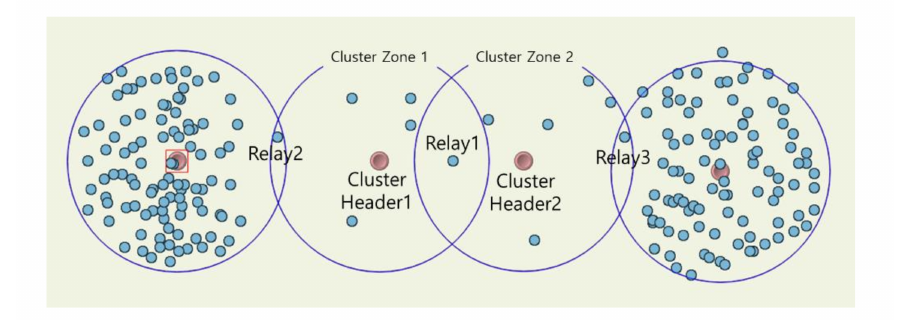
Figure 12. Simulation snapshot for generating ping-pong